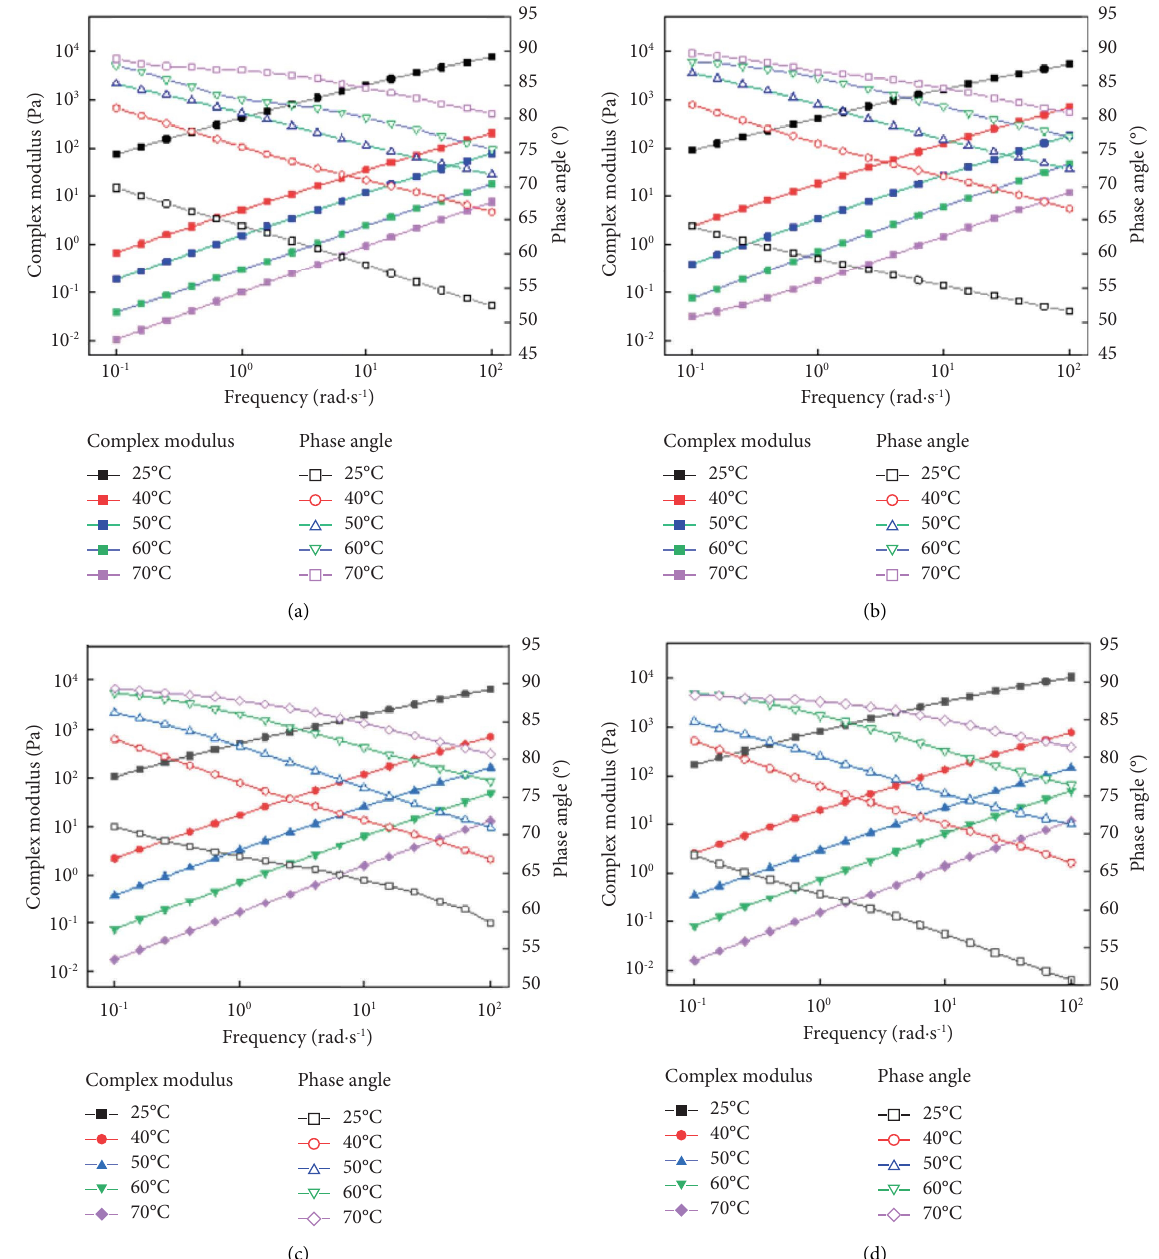
Figure 3: G ∗ and δ change curves of T770 modifed asphalt under different aging times. (a) 76.25h. (b) 152.5h. (c) 228h. (d) 305h.